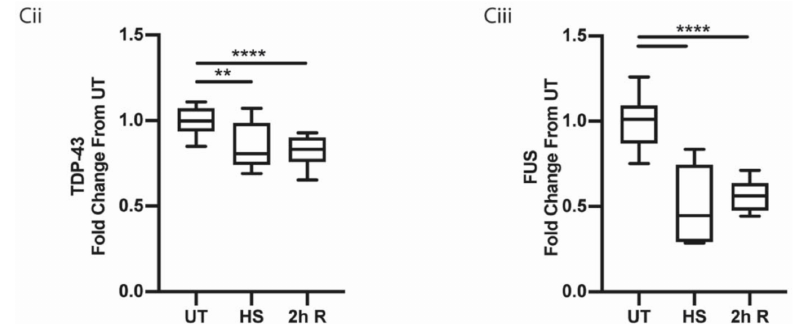
Figure 5. ALS-linked RBPs show di ff erent recovery rates when restoring nucleocytoplasmic distribution following stress. ( A ) Motor neurons were treated with 0.4 M sorbitol (OSM) and then allowed to recover for 1-h (1h R) and 2-h (2h R) time periods. Quantification of the RBP nuclear / cytoplasmic ratio was measured by individual cell analysis of > 10,000 cells for the osmotic stress and recovery times and calculated as fold change over untreated (UT) values for each experimental repeat. Data are shown as fold change from untreated values in a box and whisker plot, plotted per well from 3 control lines in 3 independent experiments. p -values from an unpaired t -test; **** = p < 0.0001. ( Ai ) SFPQ showed recovery to untreated nuclear / cytoplasmic ratio by 1 h of recovery. ( Aii ) hnRNPA1 showed full recovery to untreated values by 1 h of recovery. ( Aiii ) hnRNPK showed a similar recovery profile to SFPQ and hnRNA1, returning to untreated nucleocytoplasmic distribution by 1 h of recovery. ( B ) Motor neurons were treated with 0.4 M sorbitol (OSM) and then allowed to recover for 1-h (1h R) and 2-h (2h R) time periods. Quantification is the same as above for TDP-43 and FUS. ( Bi ) Representative images of TDP-43 and FUS in motor neurons treated with 0.4 M sorbitol (OSM) and allowed to recover for 2 h. ( Bii ) TDP-43 showed continual recovery towards untreated nucleocytoplasmic distribution following 1 h and 2 h of recovery; however, it did not recover fully. ( Biii ) FUS showed a similar recovery profile to TDP-43 and showed recovery but had not recovered to untreated values following 2 h of recovery. ( C ) The nuclear / cytoplasmic ratio was calculated from motor neurons that were subjected to 42 ◦ C for 1 h to cause heat stress (HS) and motor neurons that had recovered for 2 h following heat stress at 37 ◦ C (2h R). Data are shown as fold change over untreated values within experimental repeats. Data are shown as a box and whisker plot, plotted per well from 3 control lines from > 7000 cells for each condition in 2 independent experimental repeats. ( Ci ) Representative images of TDP-43 and FUS after 2 h of recovery following heat stress. ( Cii ) TDP-43 shows a decrease in the nuclear / cytoplasmic ratio upon heat shock, which shows no recovery after 2 h at 37 ◦ C. ( Ciii ) FUS shows a significant fold change decrease upon heat shock, which shows no recovery after 2 h; ** = p <